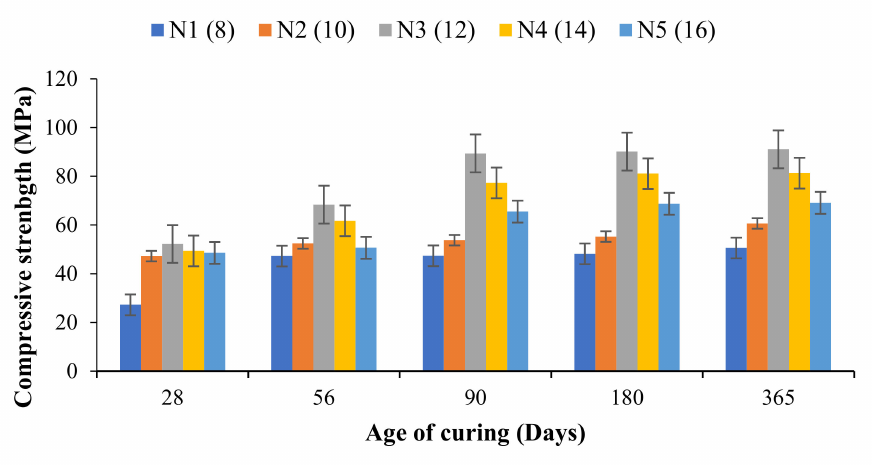
Figure 4. Compressive strength development of OPAAB.